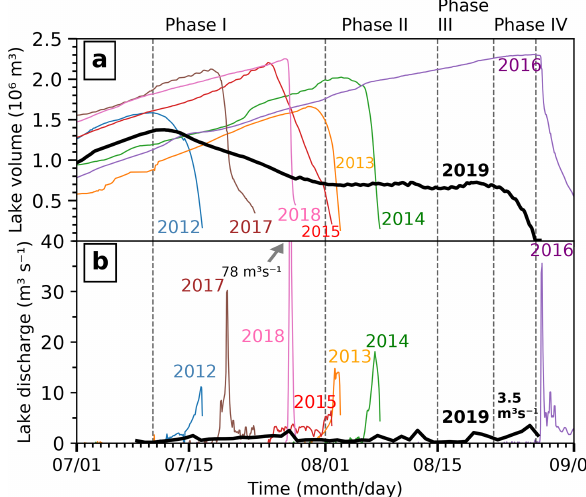
Figure 2. Lake volume (a) and lake discharge (b) during summer from 2012 to 2019. The year 2019 is represented by a black and thicker line. Discharge is shown as hourly averages for 2012 to 2018 and daily averages for 2019. Note that the 2018 discharge peak (78m 3 s − 1 ) is beyond the plotted